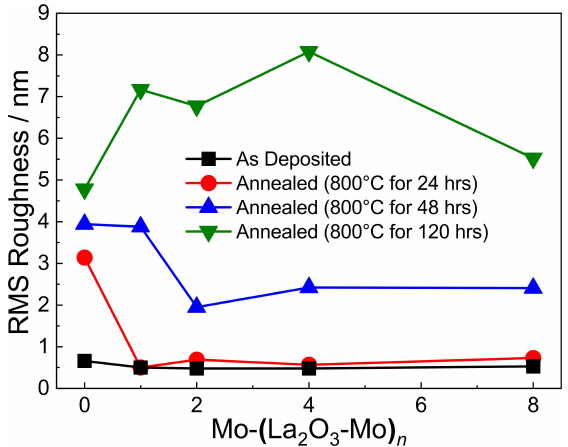
Figure 7. Root mean square (RMS) roughness of the sputtered Mo-(La 2 O 3 -Mo) n multilayers on SiO 2 /Si as a function of the number n of (La 2 O 3 -Mo) bilayers for different annealing time